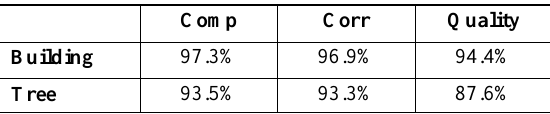
Table 6. Accuracy assessments of Building, Tree classes